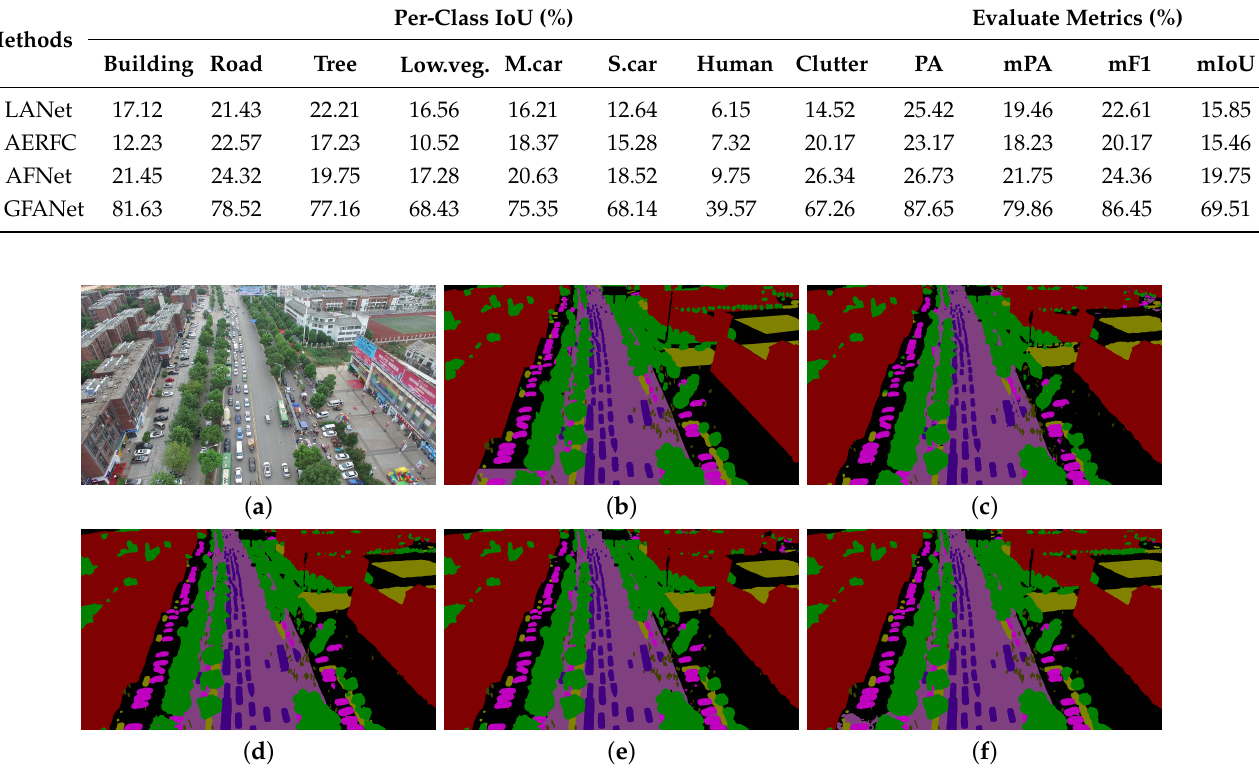
Figure 4. Visualization results of different methods on clean example test set in UAVid dataset.